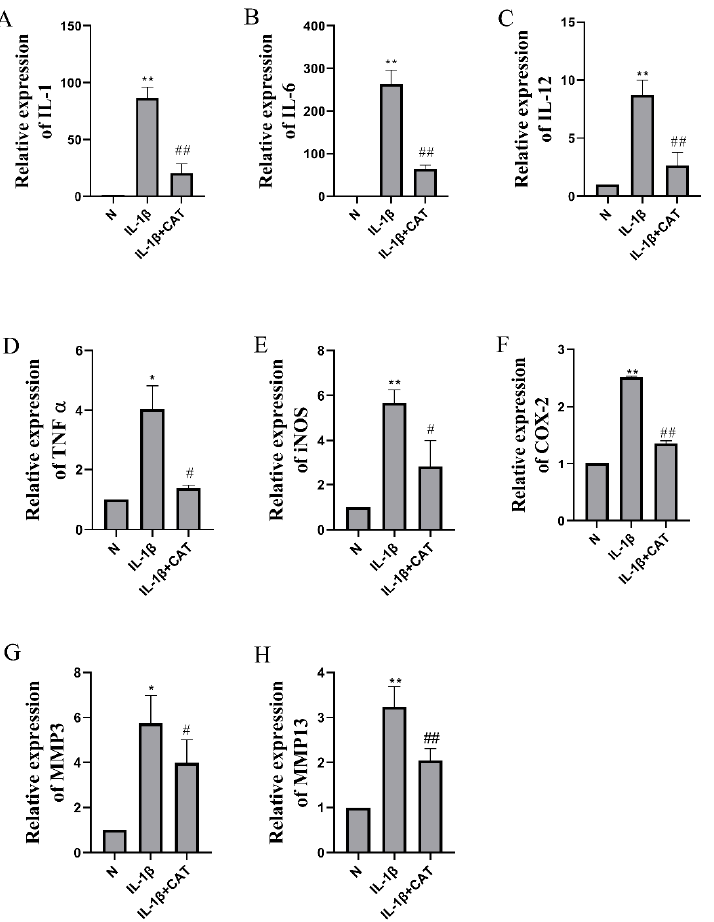
Figure 5. The effects of catalpol on the levels of inflammatory-related mRNA. ( A ) IL-1, ( B ) IL-6, ( C ) IL-12, ( D ) TNF- α , ( E ) iNOS, ( F ) COX-2, ( G ) MMP3, ( H ) MMP13. Data are mean ± S.D. of the mean (n = 3). * p < 0.05 vs. normal group (N); ** p < 0.01 vs. normal group (N); # p < 0.05 vs. IL-1 β group; ## p < 0.01 vs. IL-1 β group.